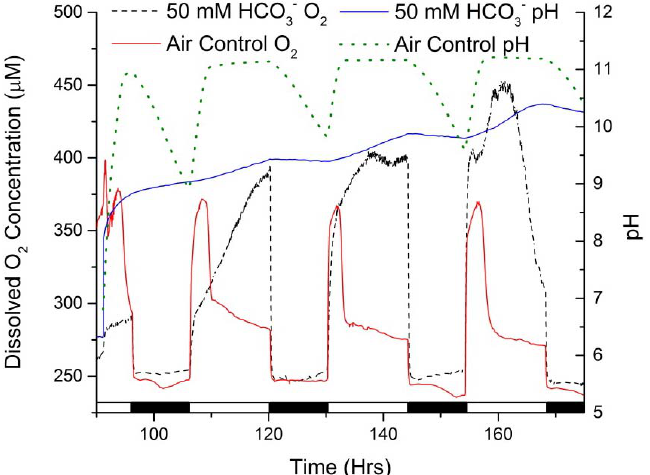
Figure 7. Dissolved oxygen (DO) concentration and medium pH of Scenedesmus WC-1 cultures which were sparged with 5% CO ( v / v ) in air until near nitrate depletion, at which 2 time (92 h) they were switched to ambient air and amended with 50 mM sodium bicarbonate. Comparison is made to cultures that did not receive the bicarbonate amendment. Growth was maintained in unbuffered Bold’s basal medium illuminated with a 14:10 L/D cycle (bottom bar) (representative individual pH and DO profiles for triplicate culturing, n =